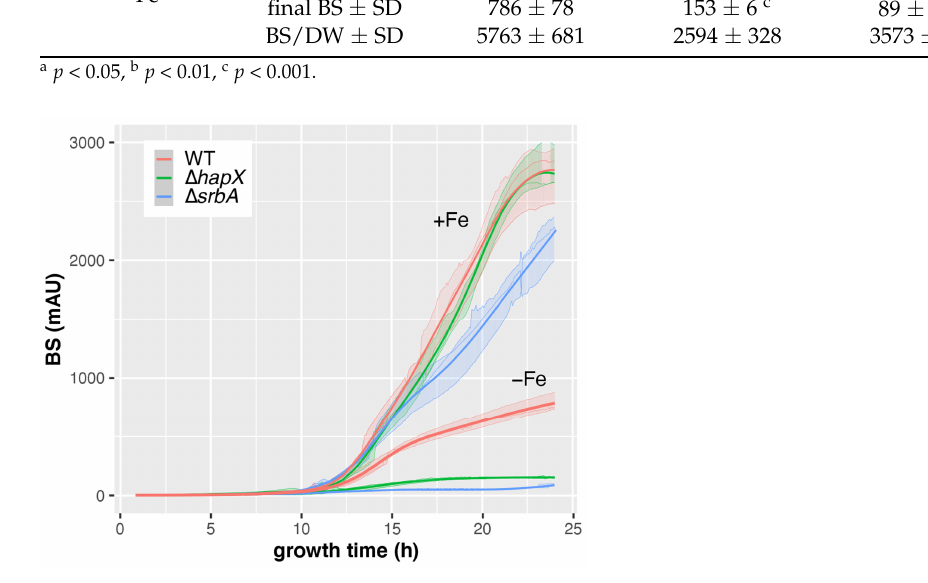
Figure 8. CGQ-mediated growth monitoring of A. fumigatus AfS77 (WT) compared to ∆ hapX and 8 ∆ srbA mutant strains cultured in biological triplicates for 24 h under +Fe and − Fe conditions. Details of the graph are as in the caption of Figure